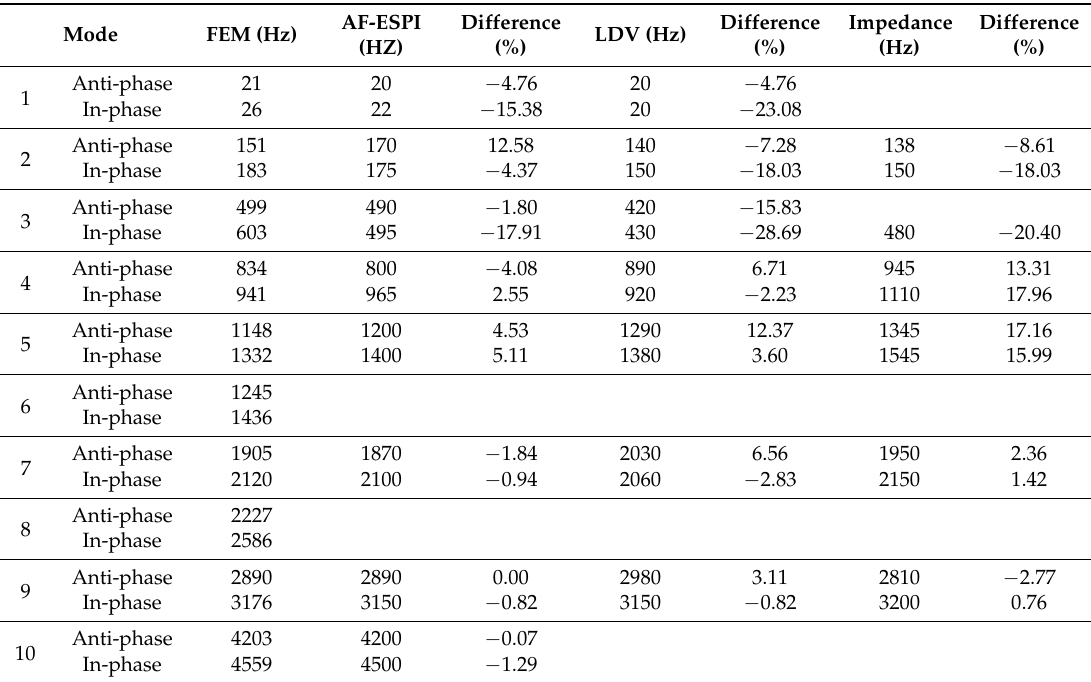
Table 4. Resonant frequencies of piezoelectric valveless micropumping element under water-coupled